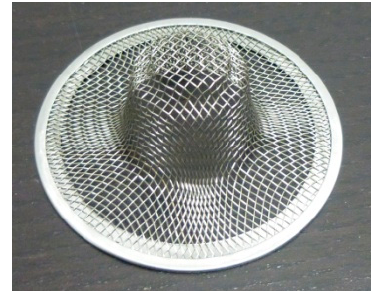
Figure A6. Drain stopper.